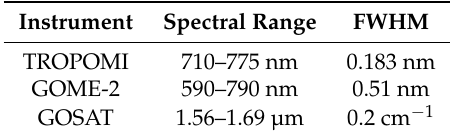
Table 6. Spectral ranges and FWHM of the Gaussian slit functions of the instruments used in the study: TROPOMI, GOME-2 and GOSAT.